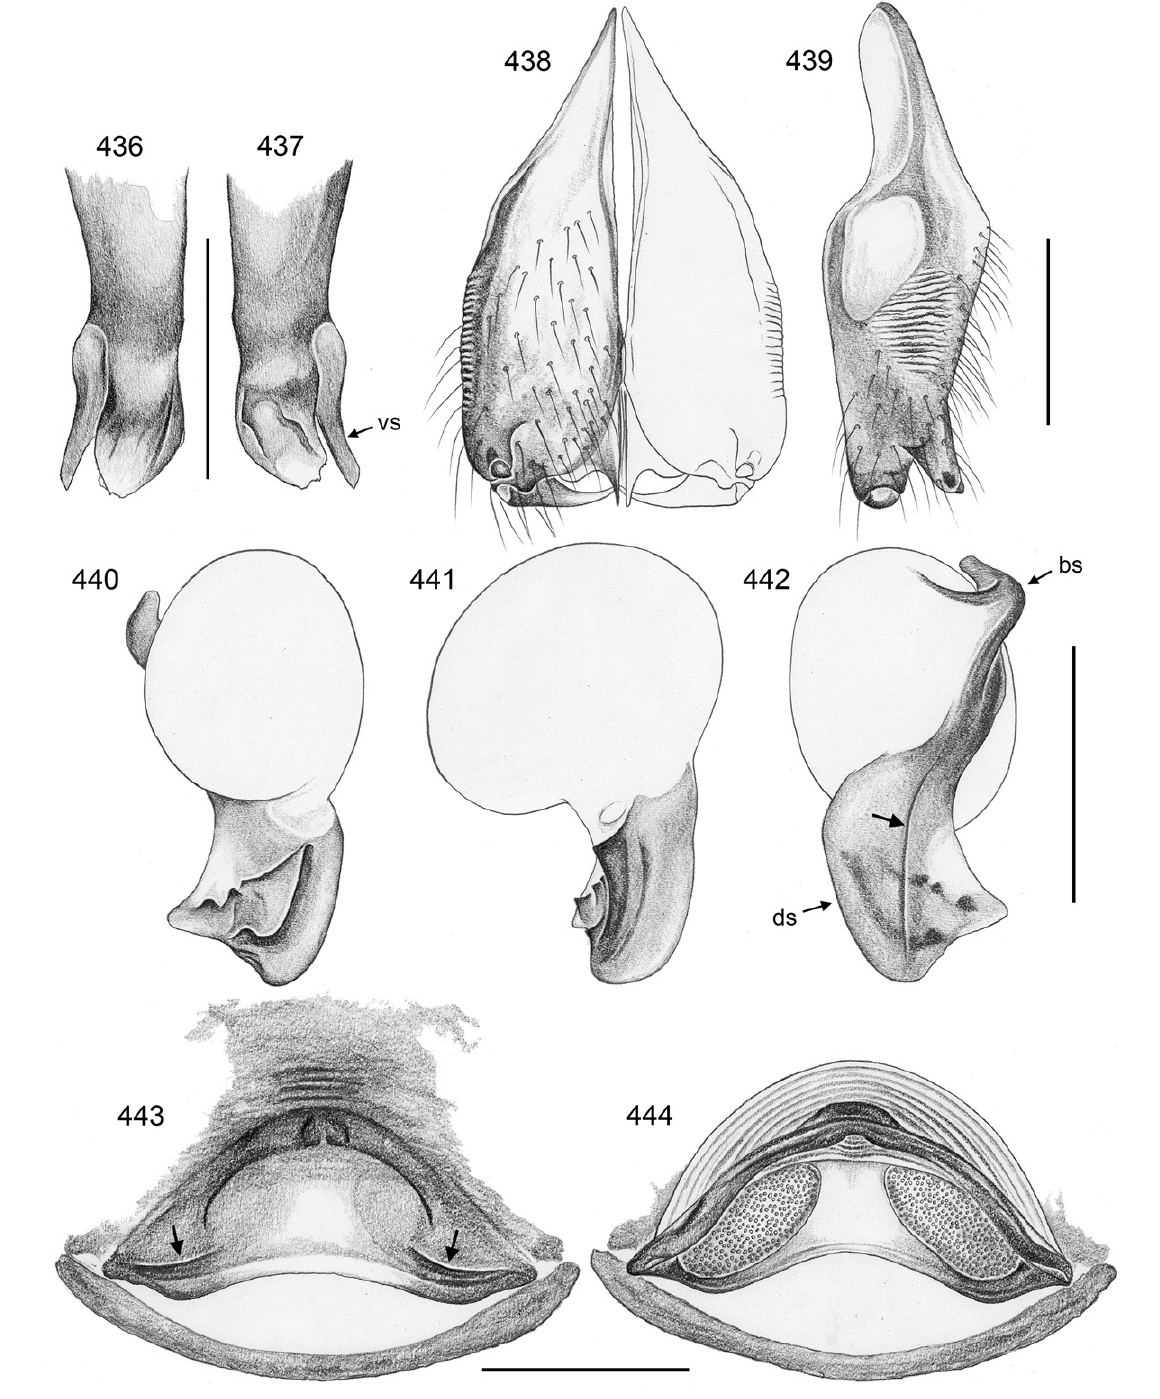
Figs 436–444. Crossopriza tiwi sp. nov.; male and female from Oman, Wadi Tiwi (ZFMK Ar 22402, Ar 22403). 436–437 . Left procursus tip, prolateral and retrolateral views. 438–439 . Male chelicerae, frontal and lateral views. 440–442 . Left genital bulb, prolateral, dorsal, and retrolateral views; arrow: retrolateral ridge. 443–444 . Cleared female genitalia, ventral and dorsal views; arrows: pockets. Abbreviations: bs = basal sclerite; ds = distal sclerite; vs = ventral sclerite. Scale bars: 436–437 = 0.2 mm; 438–444 = 0.3